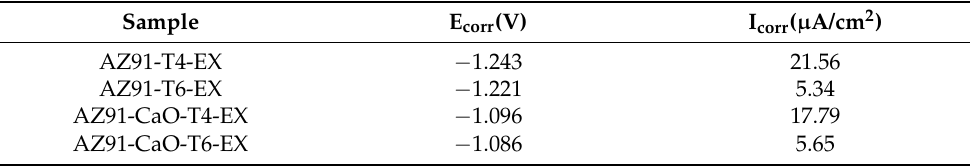
Figure 7. Electrochemical curves of AZ91-EX and AZ91-CaO-EX alloy: ( a ) polarization curves and ( b ) impedance diagram. Table 4. Electrochemical results of AZ91-EX and AZ91-CaO-EX alloys.